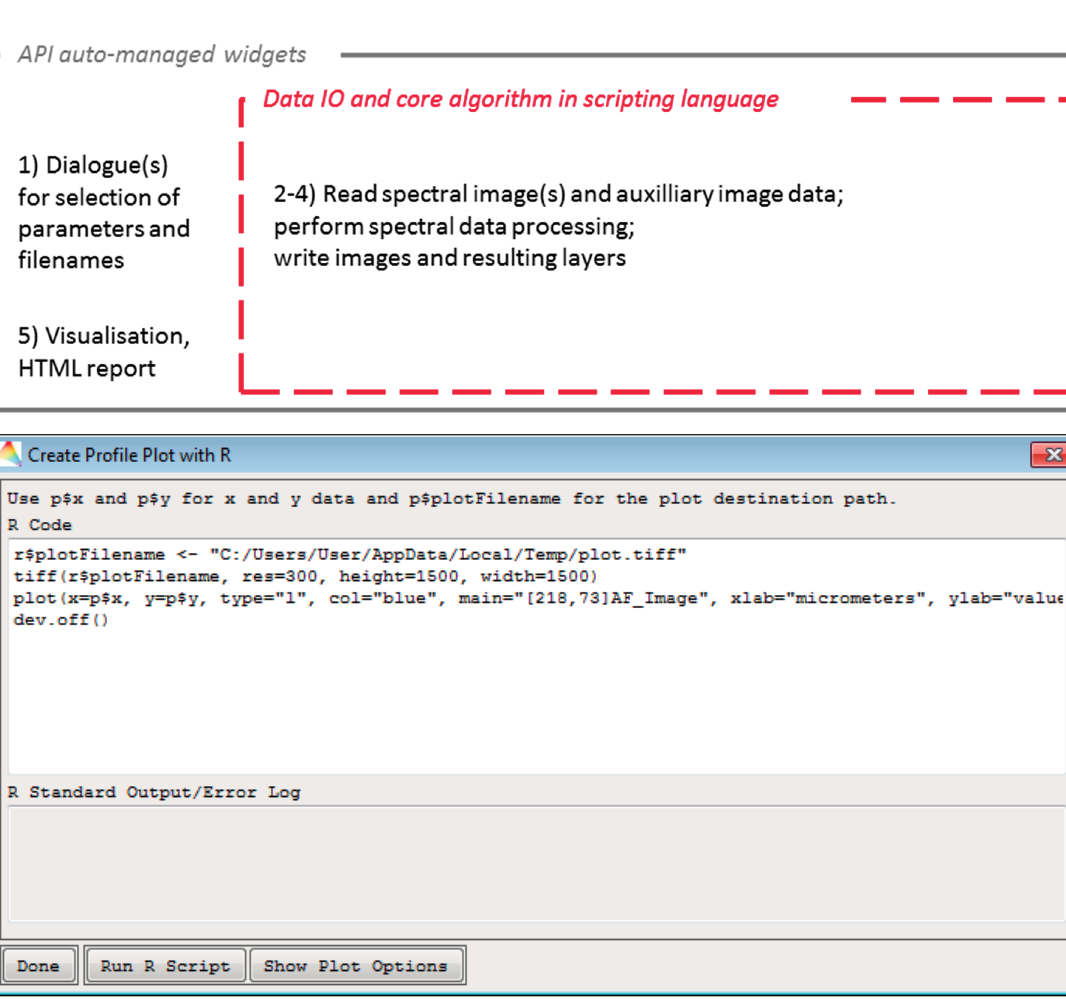
Figure 8. Adapted framework for application integration using scripting languages ( top ) and example for scripting options (here the case of the plot interface) ( bottom